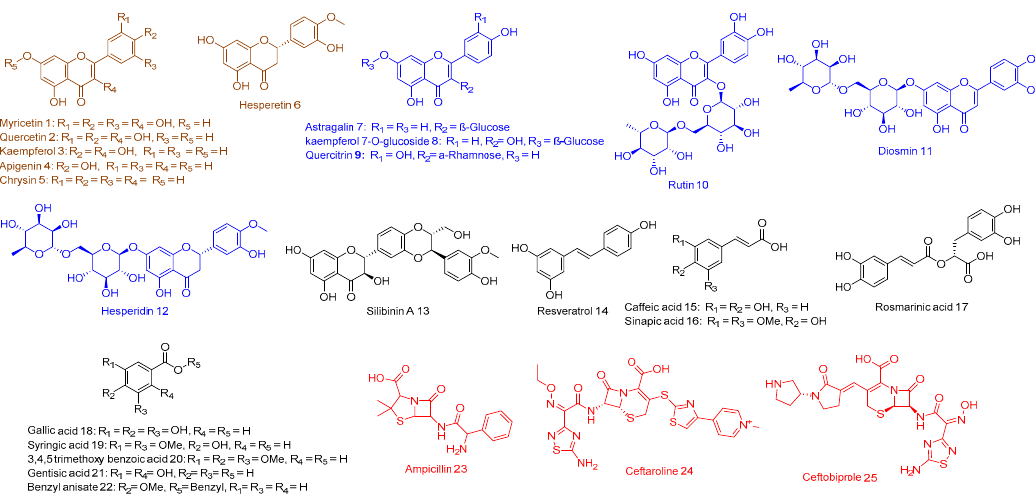
Figure 2. Compounds 1–22 of our phenolics-based library that were used in this study. This library consists of non-glycosylated flavonoids (brown color), glycosylated flavonoids (blue color), miscellaneous phenolic compounds (black color), in addition to ampicillin and the previously reported anti-MRSA agents (red color).